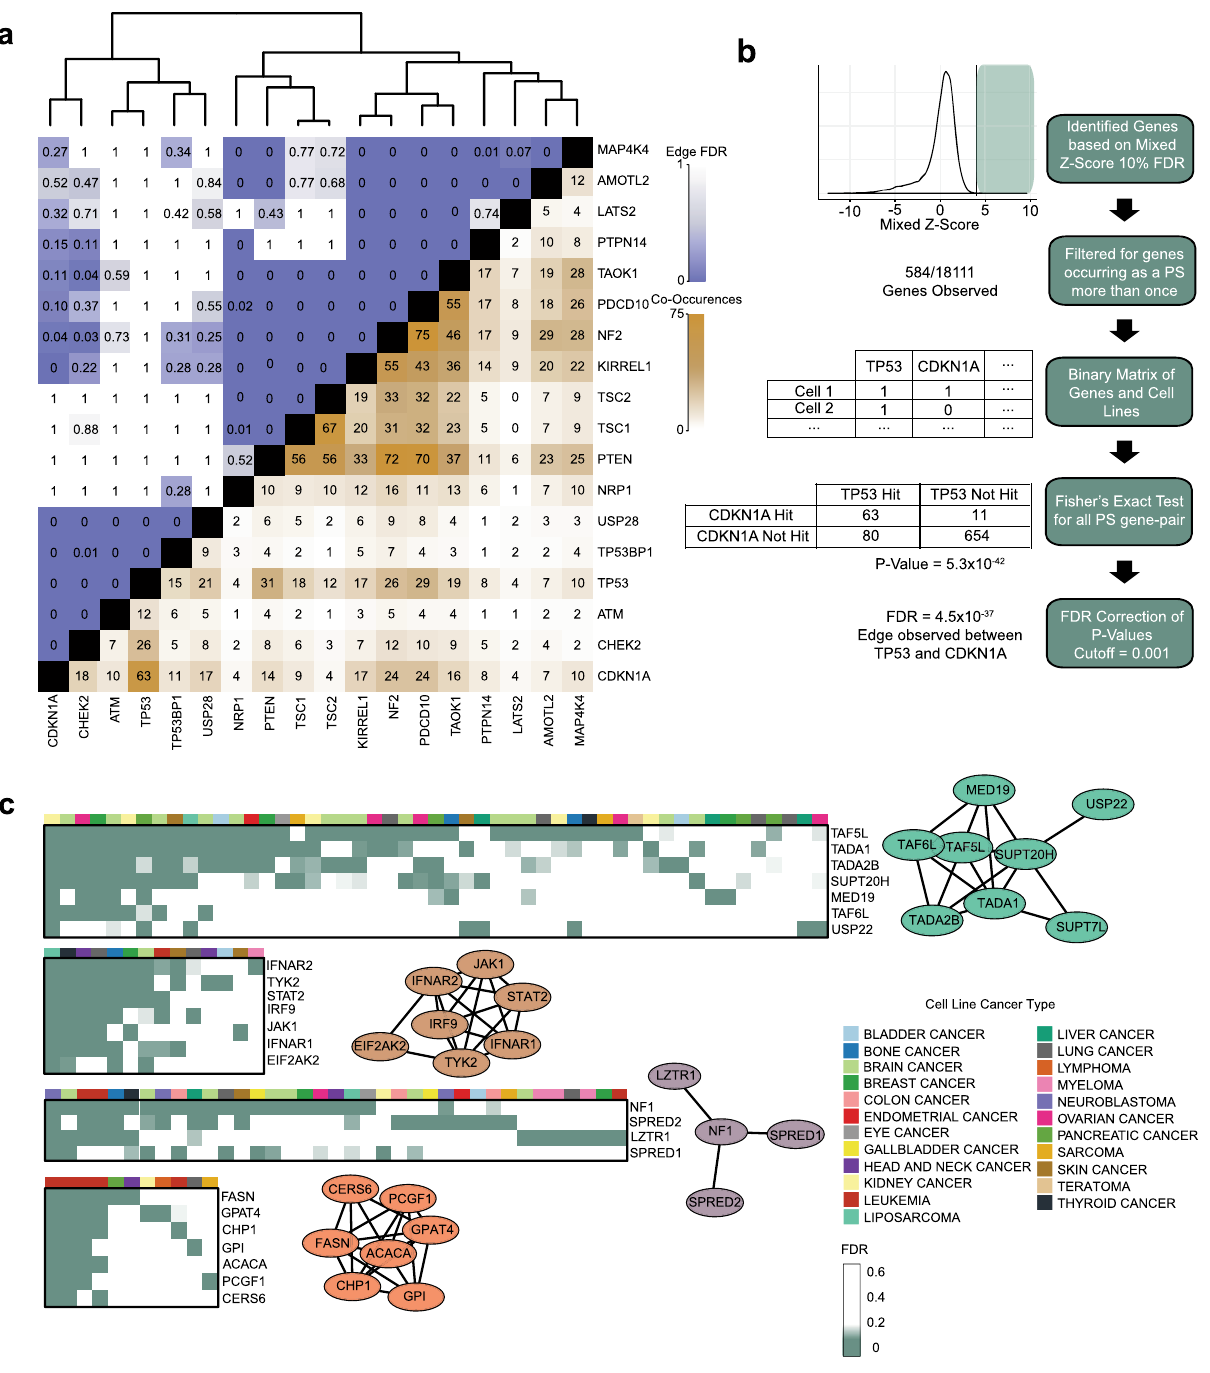
Fig. 2 Co-occurrence of PSG. a Co-occurrence/mutual exclusivity of common TSG as PSG in CRISPR screens. Brown, number of cell lines in which two genes co-occur as PSG at 10% FDR. Blue, FDR of co-occurrence. Hierarchical clustering delineates functional modules. b Pipeline for building the co-PS network. c Examples from the Co-PS network. Nodes are connected by edges at FDR < 0.1%. Heatmaps indicate the presence of PSG vs. cell